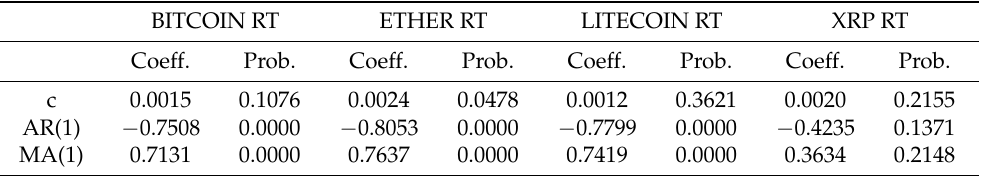
Table 8. ARIMA (1,1)